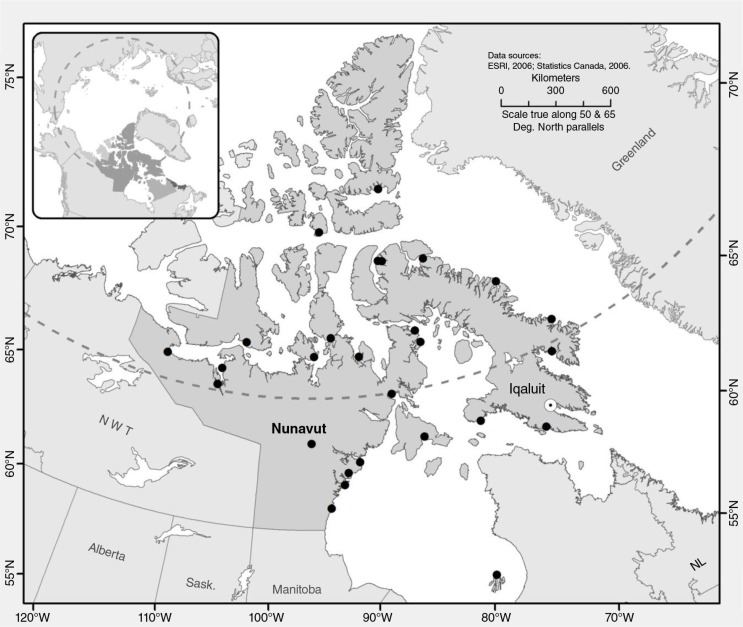
The Canadian Territory of Nunavut with Iqaluit highlighted.